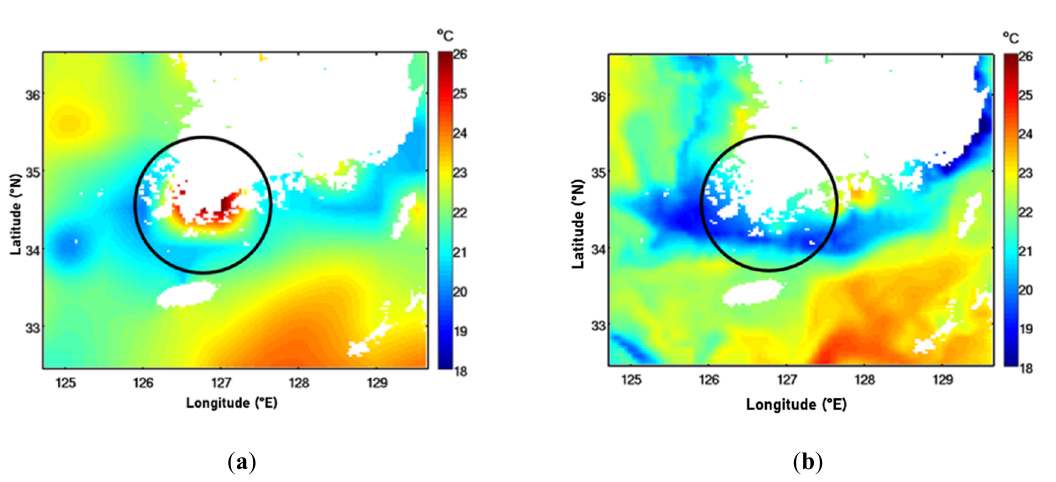
Table 3. Number of observation data and model data points.